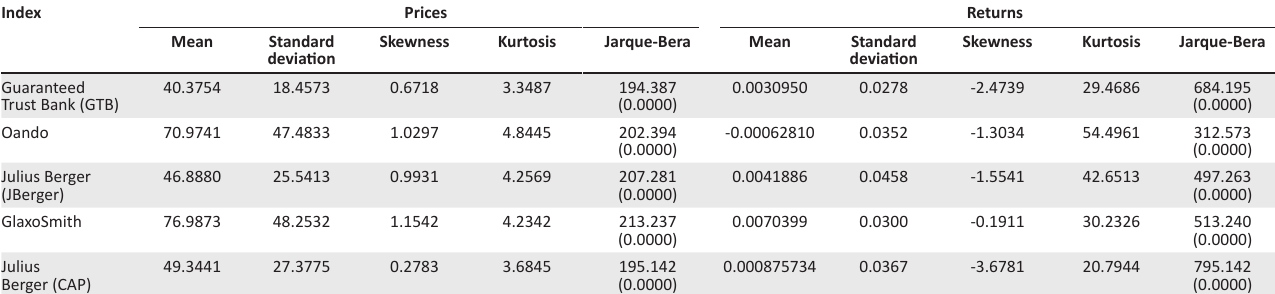
TABLE 1: Descriptive statistical summary for the daily stock